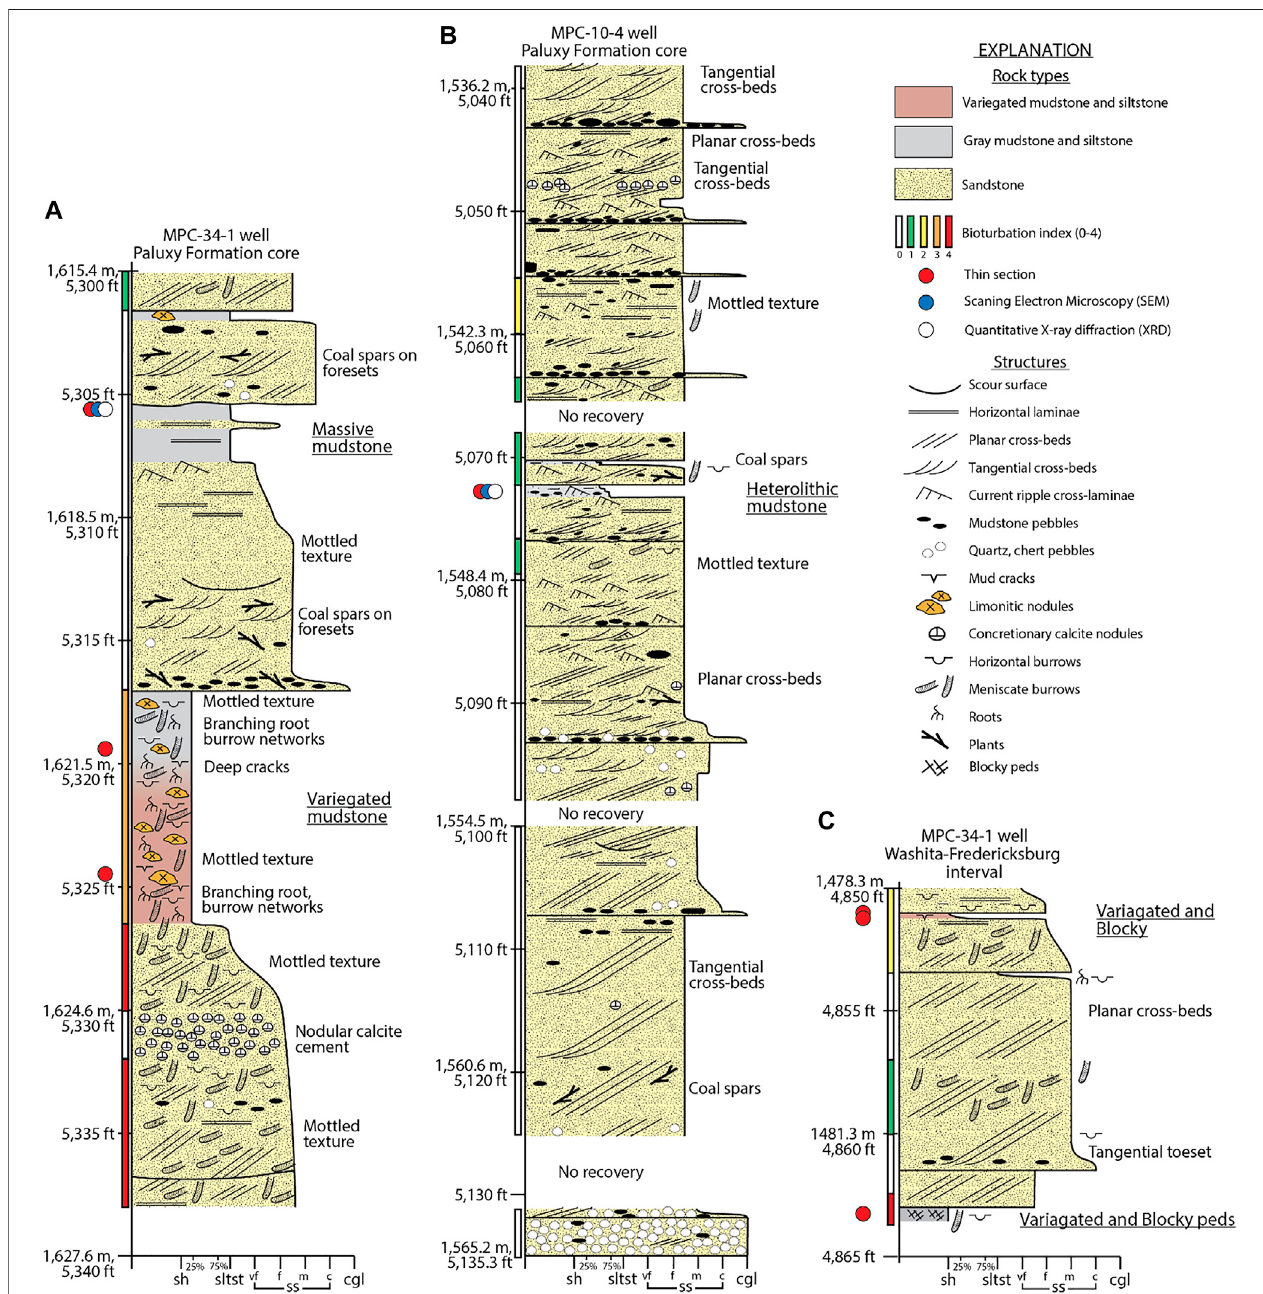
FIGURE4| Graphiccorelogs from theKemperCounty energy facilityshowingrock types, sedimentarystructures,biogenicstructures, diagenetic structures,and bioturbationindex(modi fi edfromPashinetal.,2020) (A) GraphiccorelogofthePaluxyFormation intheMPC34-1well. (B) GraphiccorelogsofthePaluxyFormationin the MPC 10-4 well. (C) Graphic core log of the Washita-Fredericksburg interval in the MPC 34-1 well.